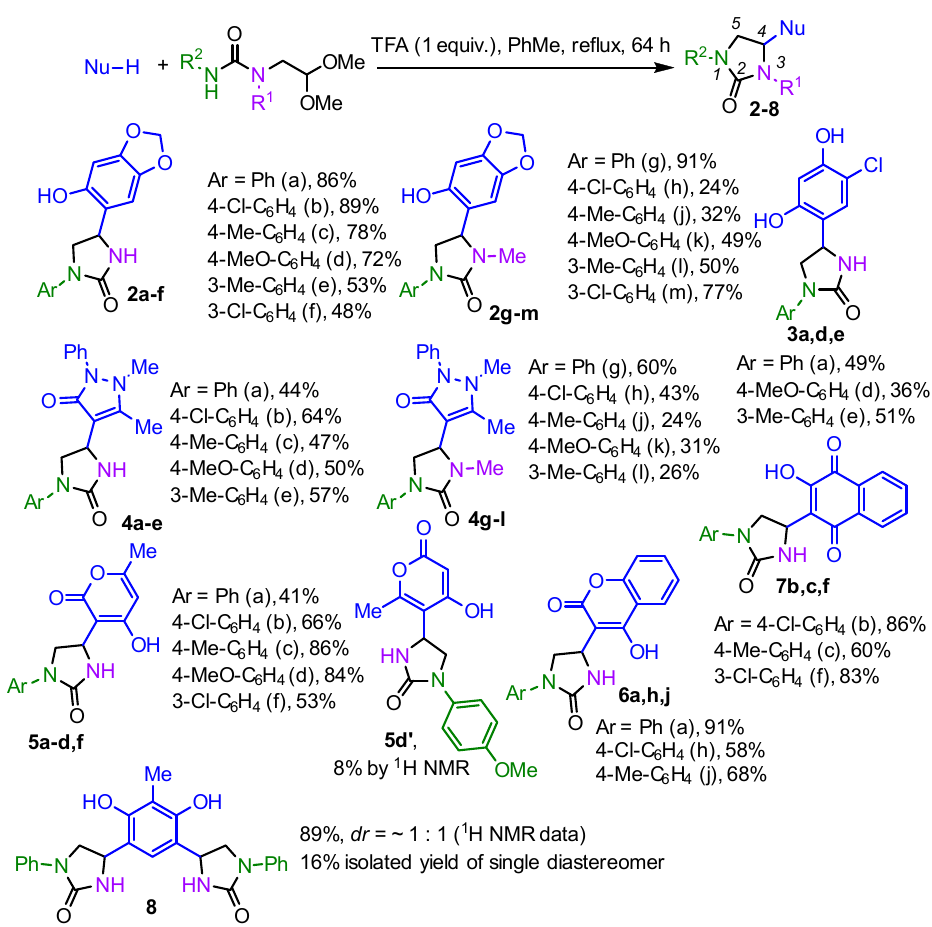
Figure 2. Molecular structure of the compounds 2j ( A ) and 2k ( B ). Ellipsoids are given with a 50% probability. In order to determine the substitution pattern on imidazolidine-2-one ring correctly for other compounds, a complete structure elucidation of the compound 2c was accom- plished by a variety of 1D/2D NMR correlation experiments ( 1 H- 1 H COSY, NOESY, 1 H- 13 C HSQC, 1 H- 13 C HMBC, 1 H- 15 N HMBC). First, the signals of protons and carbon atoms were assigned used the set of 2D homo- and heteronuclear correlation experiments. Then, the 1D NOESY experiment was carried out. Selective excitation of ortho -protons (H a ) of